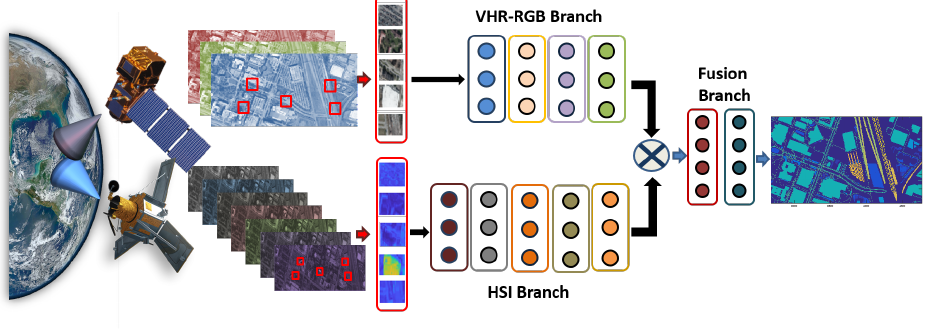
Figure 1. Processing pipeline for the proposed multimodal CNN. The overall network architecture is composed of three parts, one for processing the RGB (top), and one for the HSI (bottom), are are fused into a third part (right) in order to produce the classification results.